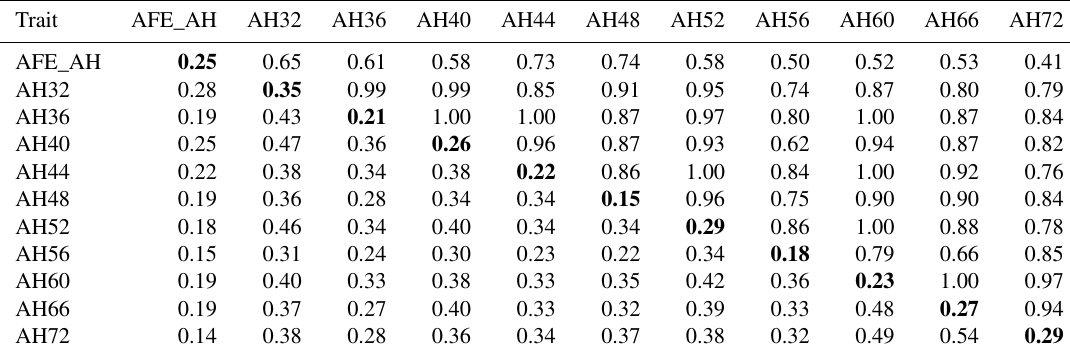
Table 2. Phenotypic correlation and genetic parameters of albumen height. Trait